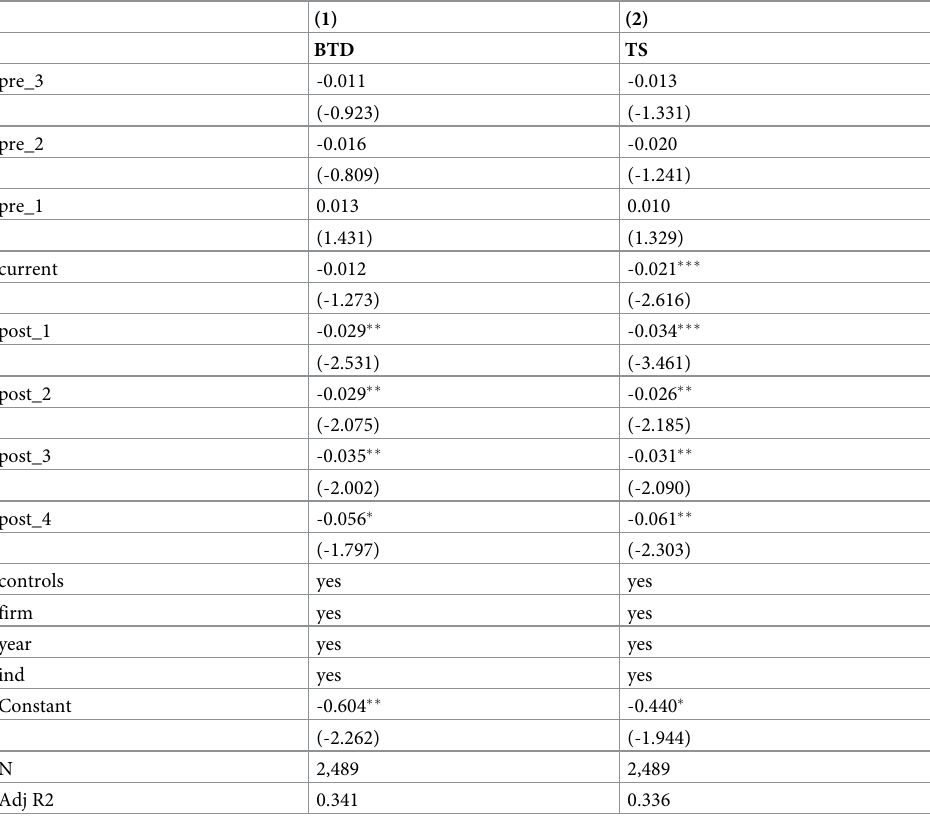
Table 6. Dynamic